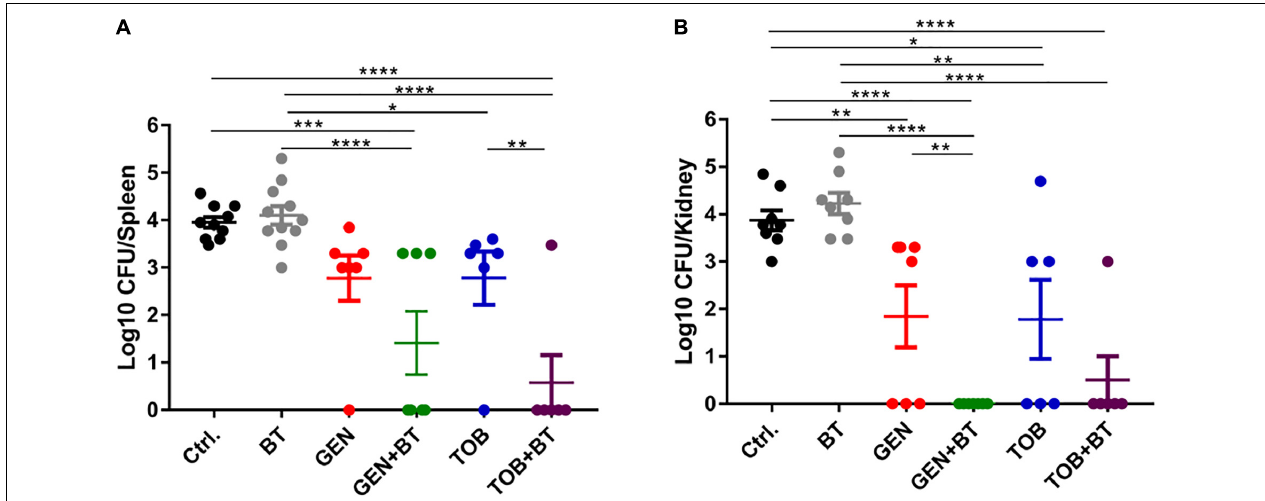
FIGURE 7 | Bacterial quantities displayed as log10 (CFU/mice) in all treatment groups. (A) Spleen and (B) Kidney. After 1 h following i.p. injection of 500 µ L of 1 McF of E. faecalis ATCC 29212 with 5% mucin, BT 30 mg/kg (i.p.) combined with GEN/TOB 30 mg/kg (s.c.) was administered twice daily for a total of 3 days. * p < 0.05, ** p < 0.01, *** p < 0.001, **** p < 0.0001. N = 6–11 mice per